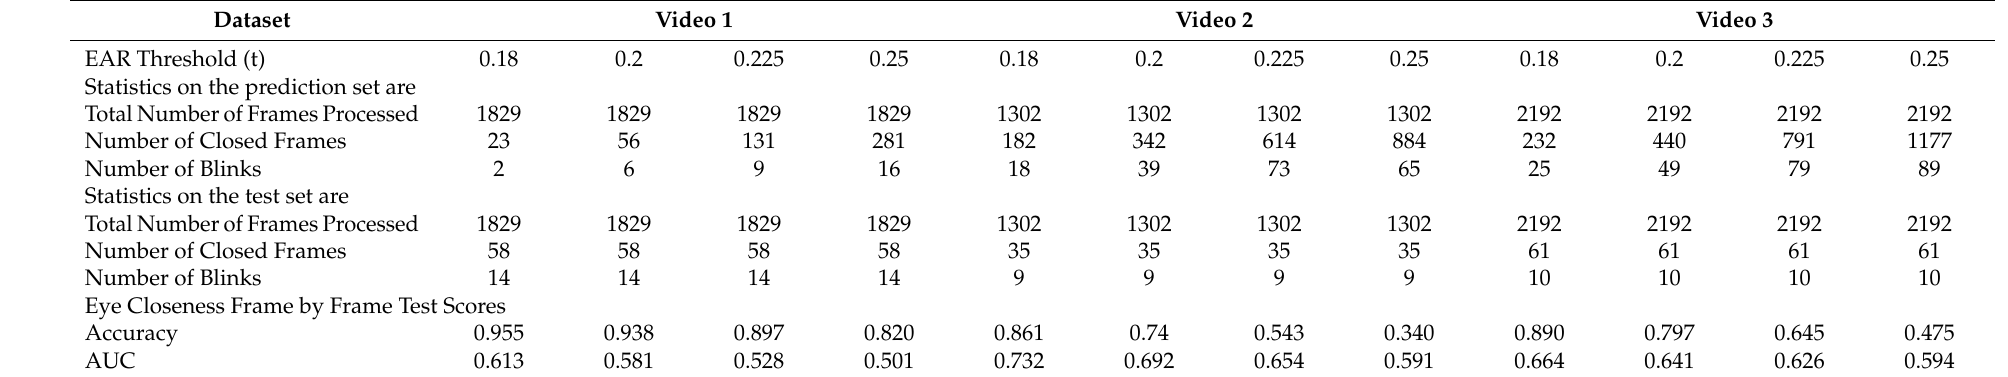
Table 3. Statistics for prediction and test sets (Eye Blink Dataset).